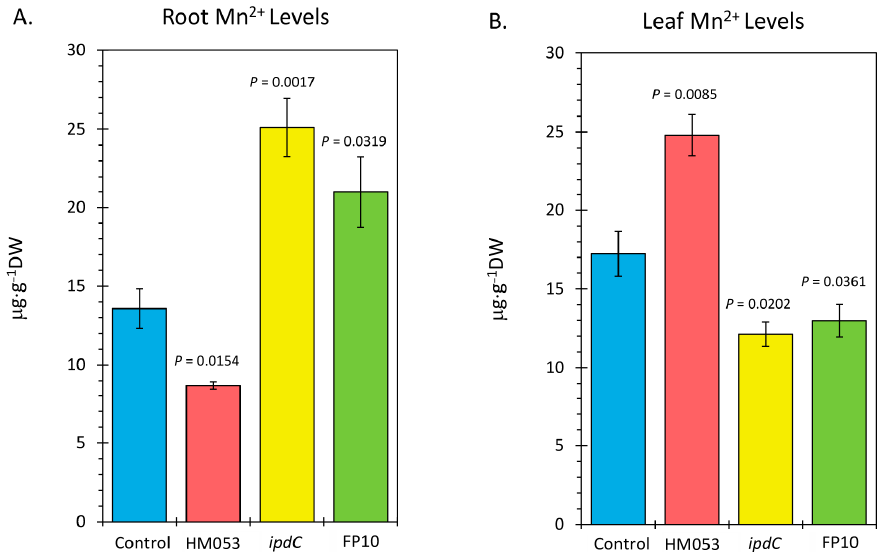
Figure 4. Inductively coupled mass spectrometry (ICP-MS) analysis of plant tissues for Mn-55. Panel ( A ): root concentrations presented in micrograms of manganese per gram of dry weight tissue ( µ g · g − 1 DW). Panel ( B ): leaf concentrations presented in µ g · g − 1 DW. Data bars reflect mean values ± SE. The number of biological replicates is defined by the number of plants we examined per treatment (control, N = 6 plants; HM053-inoculated, N = 6 plants; ipdC -inoculated, N = 4 plants; FP10, N = 6 plants). p values < 0.05 were considered statistically significant.